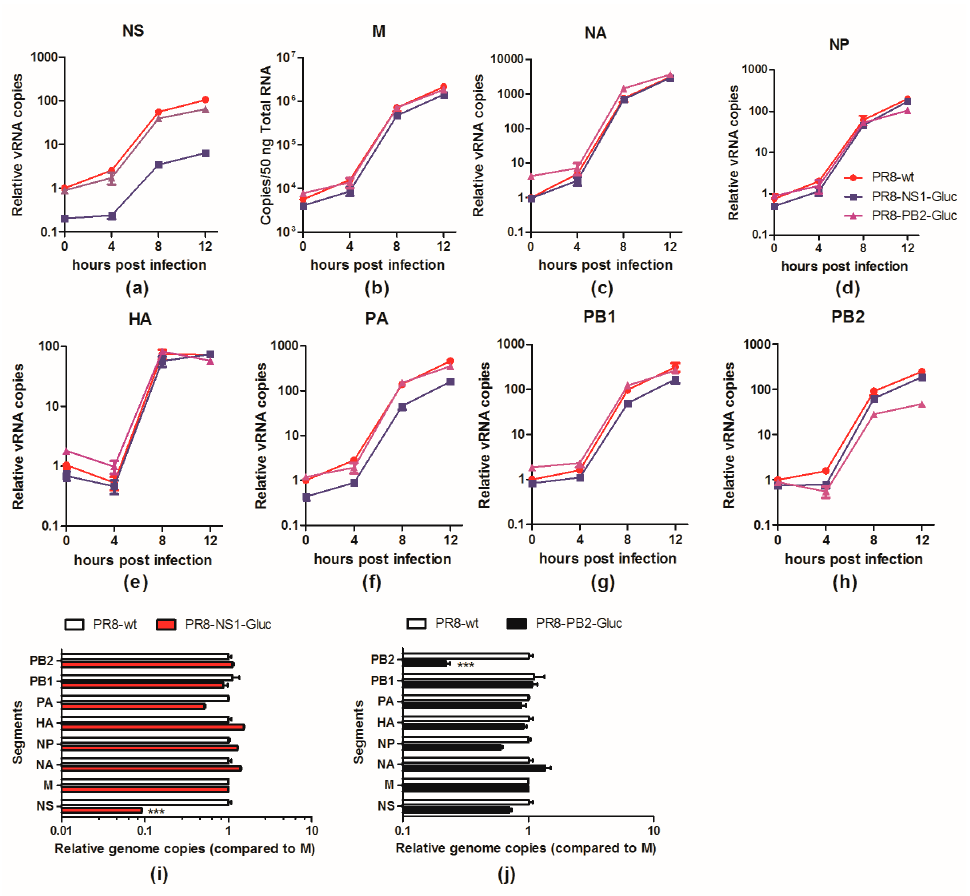
Figure 5. The replication of vRNA NS-Gluc and PB2-Gluc were impaired in infected cells. ( a – h ) Replication kinetics of indicated vRNAs in MDCK cells infected with PR8, PR8-NS1-Gluc, PR8-PB2-Gluc, respectively; ( i , j ) The relative concentrations of vRNAs in MDCK cells infected with indicated reporter IAVs were presented as the ratios of each vRNA segment versus M. The standard deviations were calculated based on three replicates. *** p < 0.001, students’ t test.